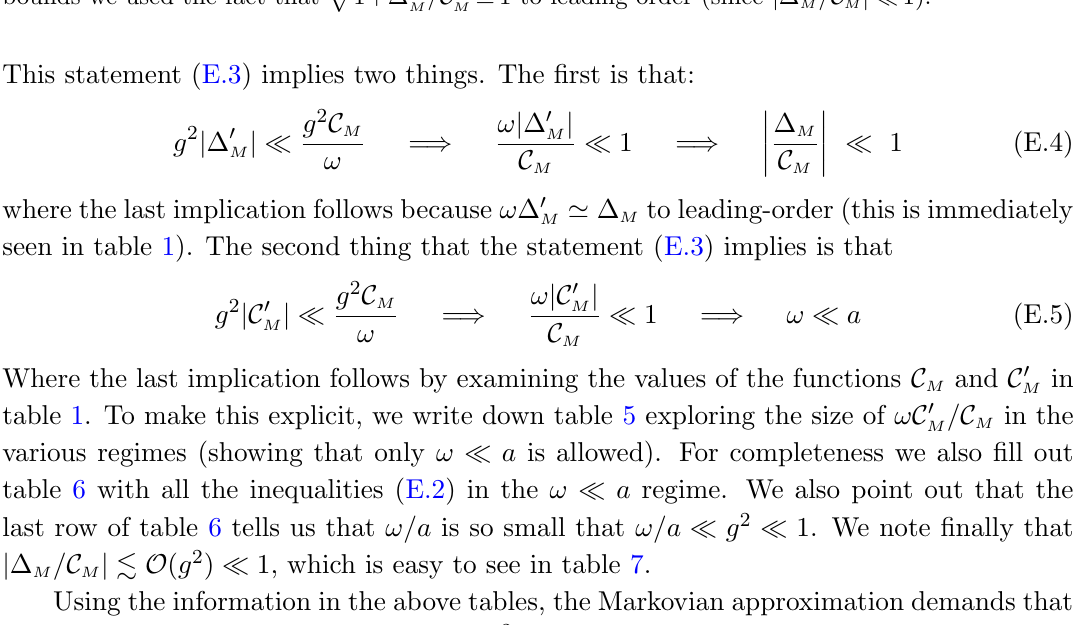
Using the information in the above tables, the Markovian approximation demands